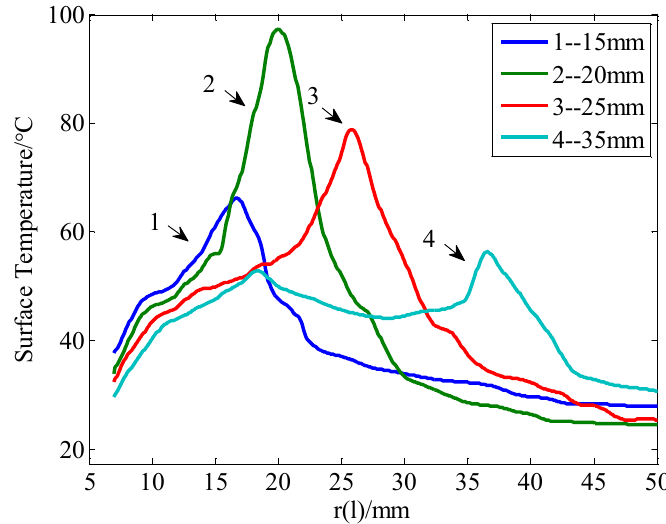
Figure 11. Numerical simulation of surface temperature distribution of insulators with dry bands in different positions.